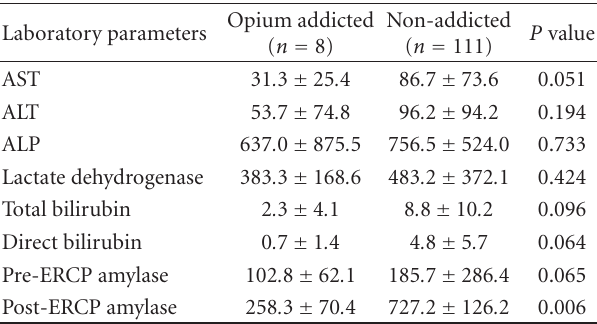
Table 3: Liver function parameters in opium-addicted and non- addicted patients with SOD and undergoing